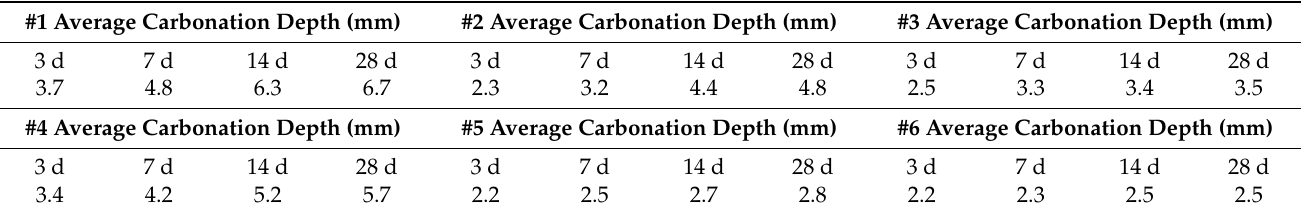
Table 7. Concrete carbonation performance test